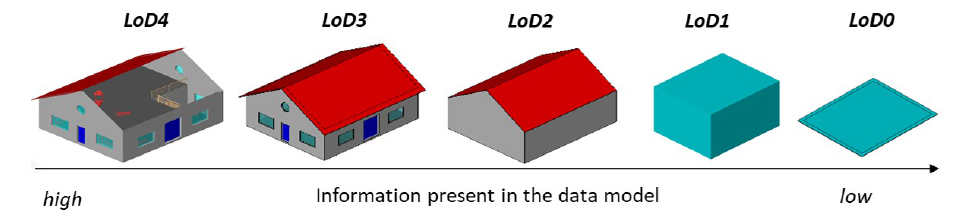
Figure 2. The five different Levels of Detail (LoD) in CityGML. Image adapted from [9,49].